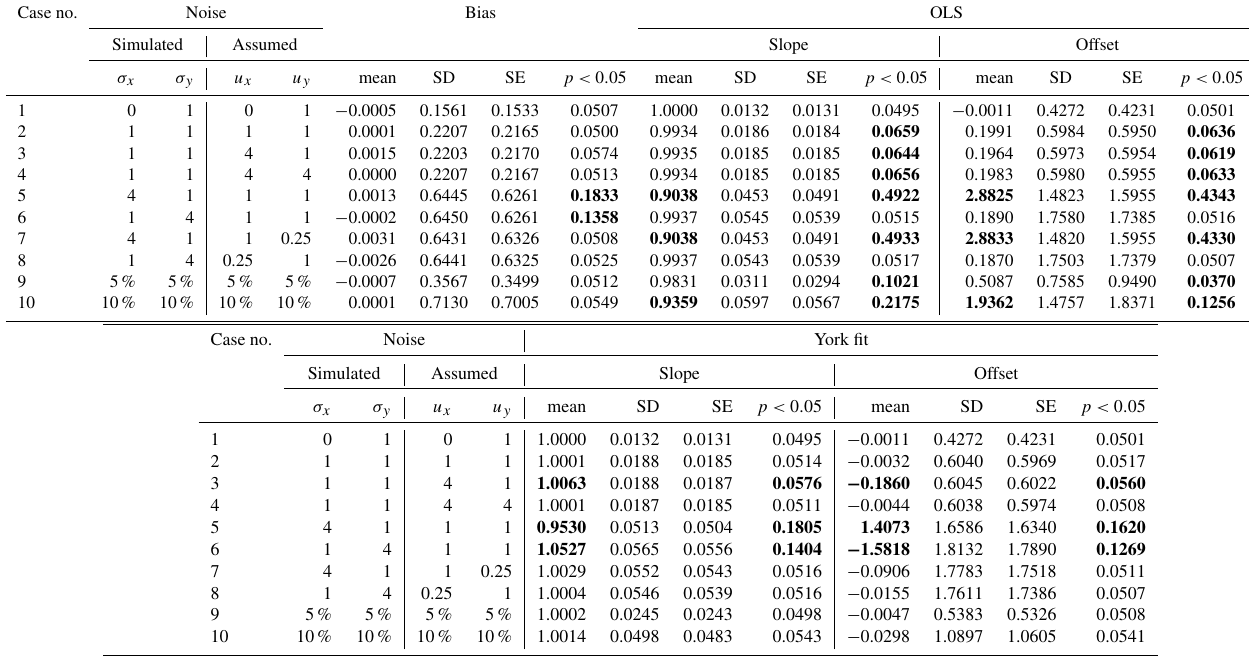
Table C1. Monte Carlo tests of linear regression using the ordinary least-squares (OLS) and the York et al. (2004) method. In all simulated cases, the true slope is 1 and true offset is 0. Noise is simulated in both variables according to the standard deviation values indicated in the first two columns. Each data set was run for 10 5 simulations. The OLS method assumes noise is present only in the y variable. The York method accounts for errors in both variables, with uncertainties specified in the third and fourth columns. The other columns report the mean and standard deviation (SD) of estimated parameters (bias, slope, and offset) and their mean standard errors (SE). The column “ p < 0 . 05” indicates the fraction of results that have p values smaller than 0.05. The expected value for the latter is 0.05. Mean values and p < 0 . 05 values that differ significantly from the expected values are highlighted in